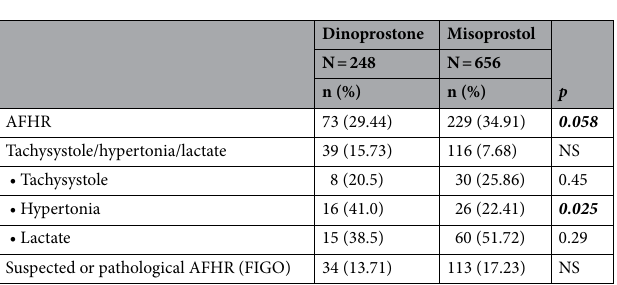
Table 5. Fetal heart rate abnormalities during labor. AFHR: Abnormal fetal heart rate. FIGO: International Federation of Gynecology and Obstetrics. Significant values are in